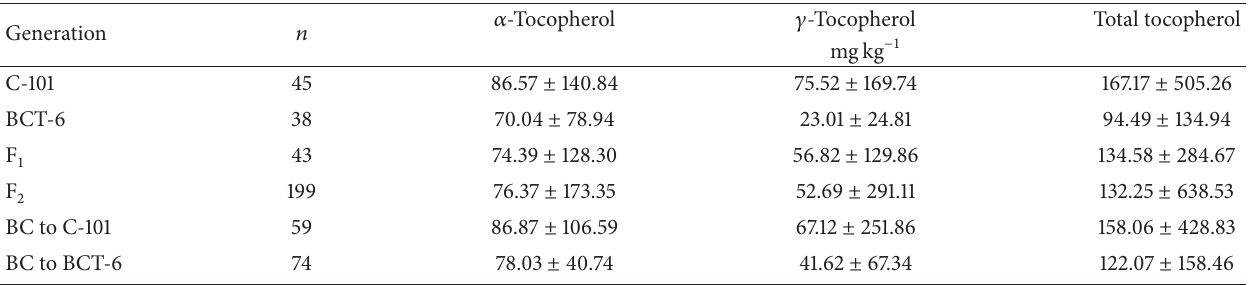
Table 1: 𝛼 -Tocopherol, 𝛾 -tocopherol, and total tocopherol contents (mean ± variance, in mg kg −1 air-dried seed) in the Ethiopian mustard lines C-101 and BCT-6 and the F 1 , F 2 , and BC generations derived from their cross.